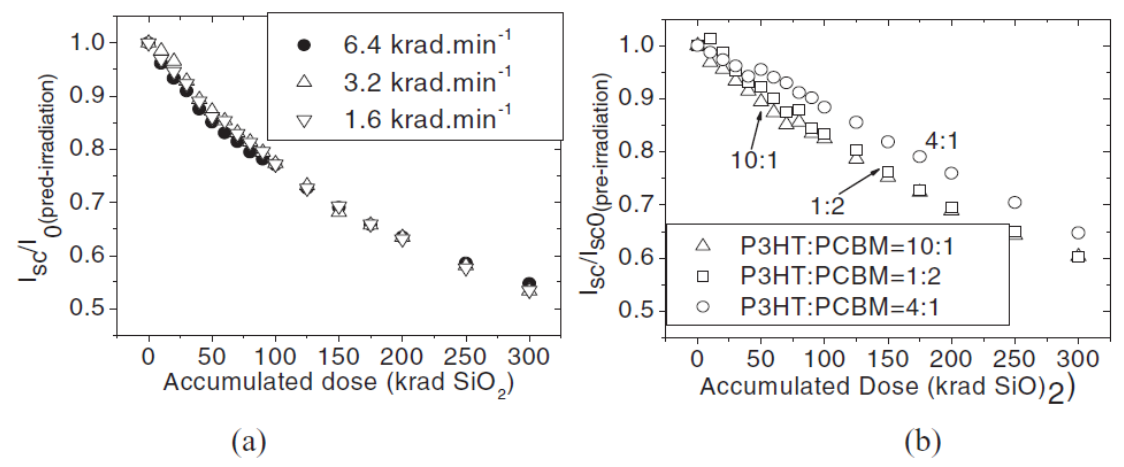
Figure 13. Effect of X-ray dose on normalized short-circuit current (I sc ) for ( a ) various dose rates of P3HT:PCBM in the ratio 1:1 and ( b ) for different w / w ratios of P3HT:PCBM at a fixed rate of 6.4 Krad/min. Copyright permission from [138].